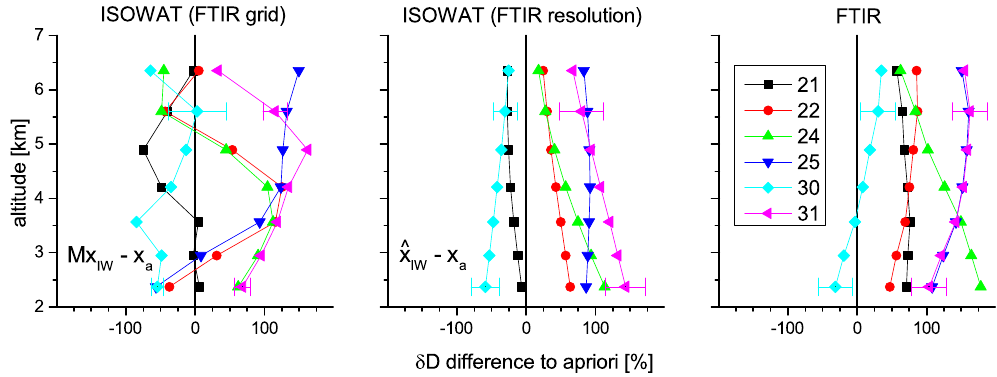
√ n − 1 values according to √ n − 1).